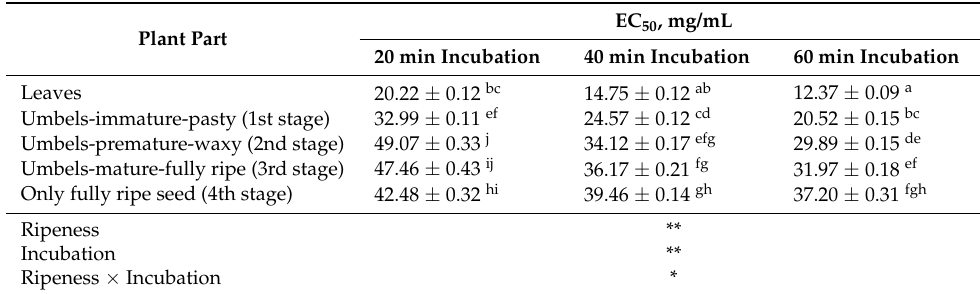
Table 4. EC 50 values of essential oil from the fennel leaves, umbels, and seeds after different periods of incubation with the DPPH